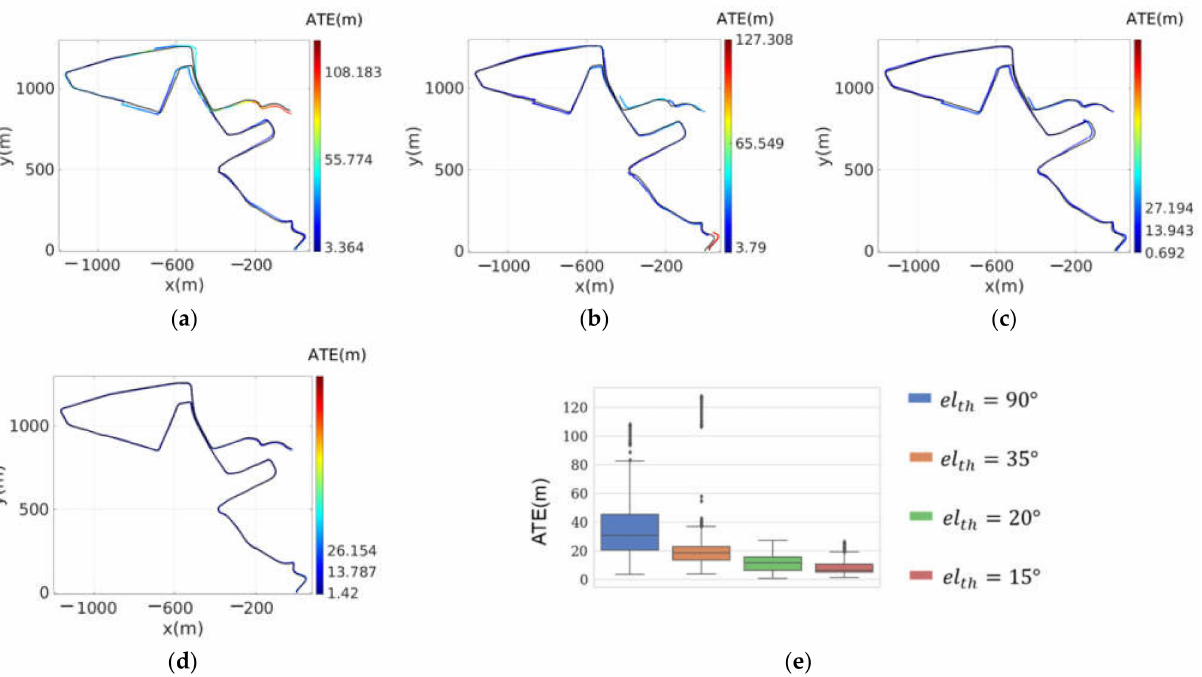
Figure 11. ( a – d ) plots the trajectory generated by the adaptive fusion pipelines with the thresholds el th for the GNSS-RTK availability assessment set as 90 ◦ , 35 ◦ , 20 ◦ and 15 ◦ respectively on urban-3. The black trajectory is the ground truth. The ATE of each estimated position is mapped on the trajectory referring to the color bar with the same scale on the right, on which the largest and the smallest tick label represents the maximum and the minimum ATE respectively while the middle one represents the midrange of them. ( e ) shows the boxplot of the ATE on the whole trajectory produced by the four